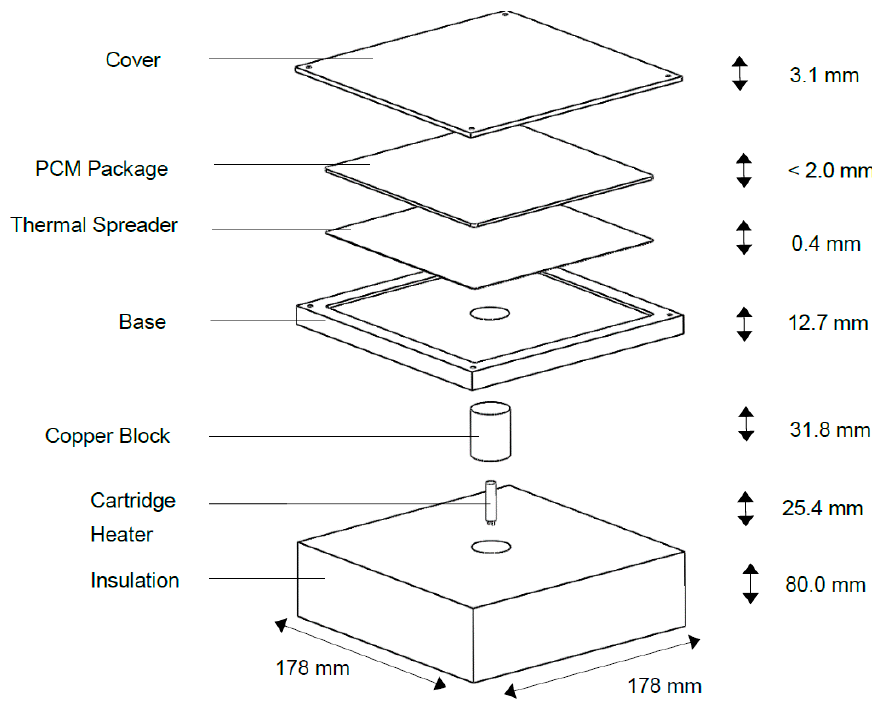
Figure 1. Exploded view of the experimental apparatus showing the thickness of the individual components. Appl. Sci. 2019 , 9 , x FOR PEER REVIEW